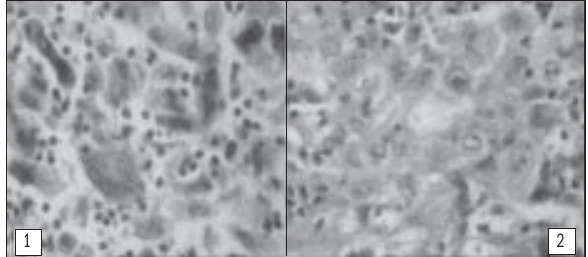
Figura 2B – Detalhes da micrografia anterior mostrando os componentes de sincício (1) e citotrofoblasto (2) malignos (hematoxilina-eosina,